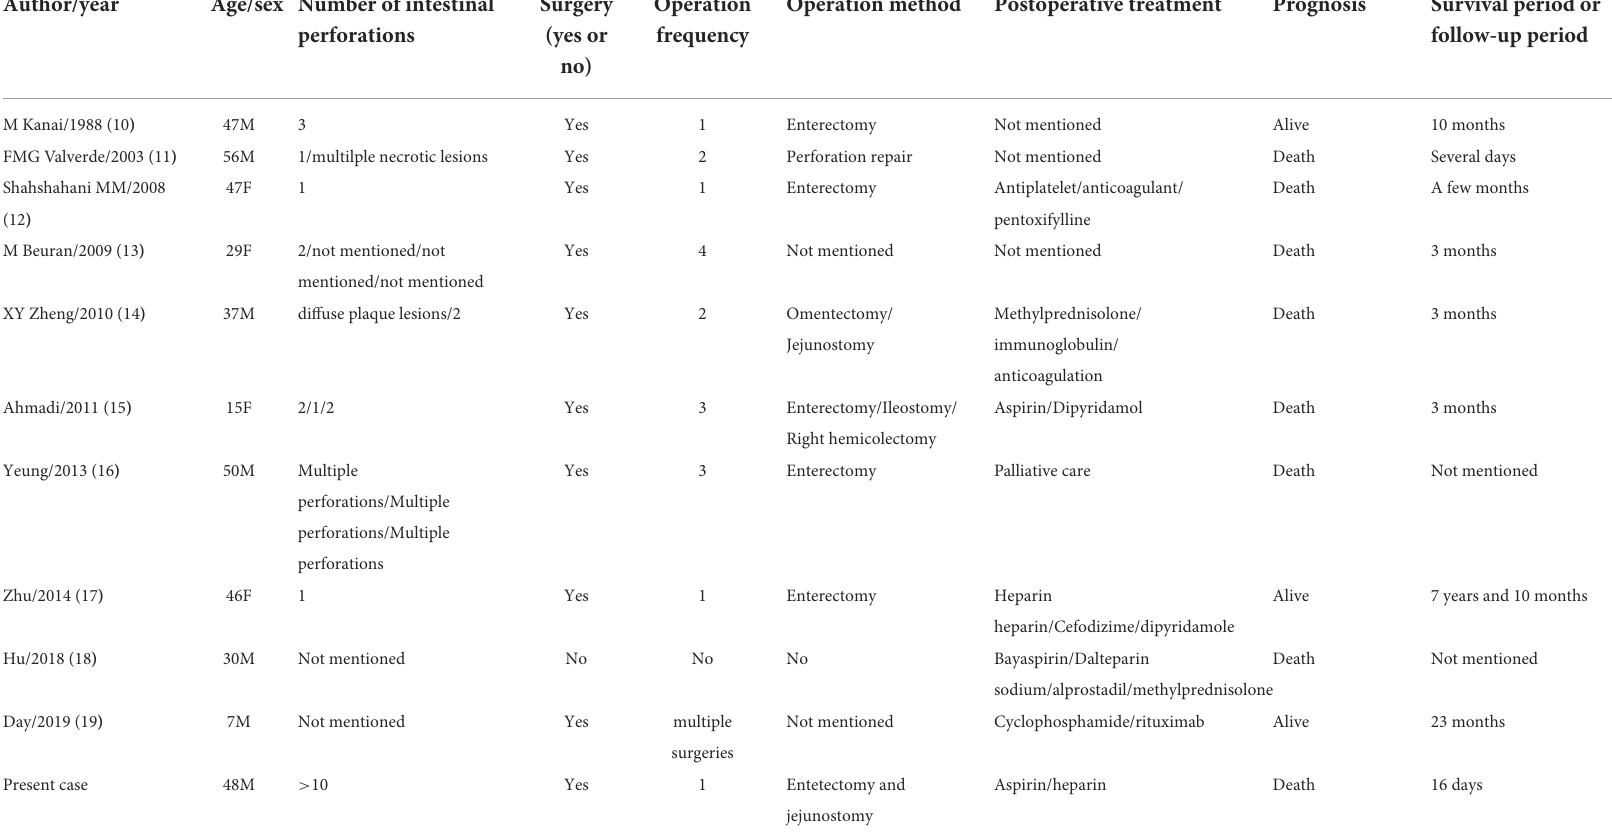
TABLE 1 Previous case reports of MAP and intestinal